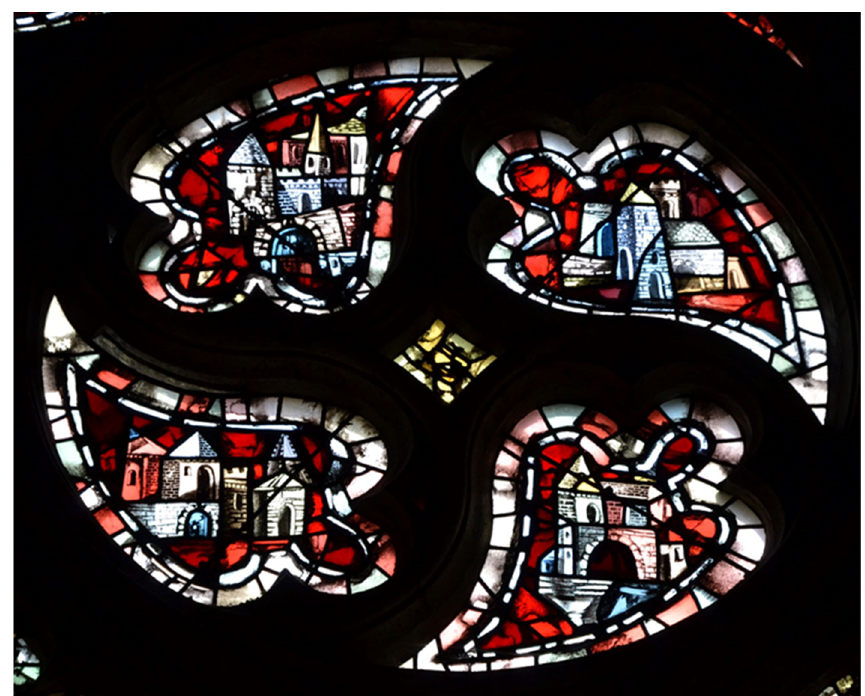
Figure 18. Saint-Lô, Church of Notre-Dame, Saint-Thomas chapel, Life of Saint Thomas window, 1968, detail, tracery containing depictions of churches and other architectural structures. © author.